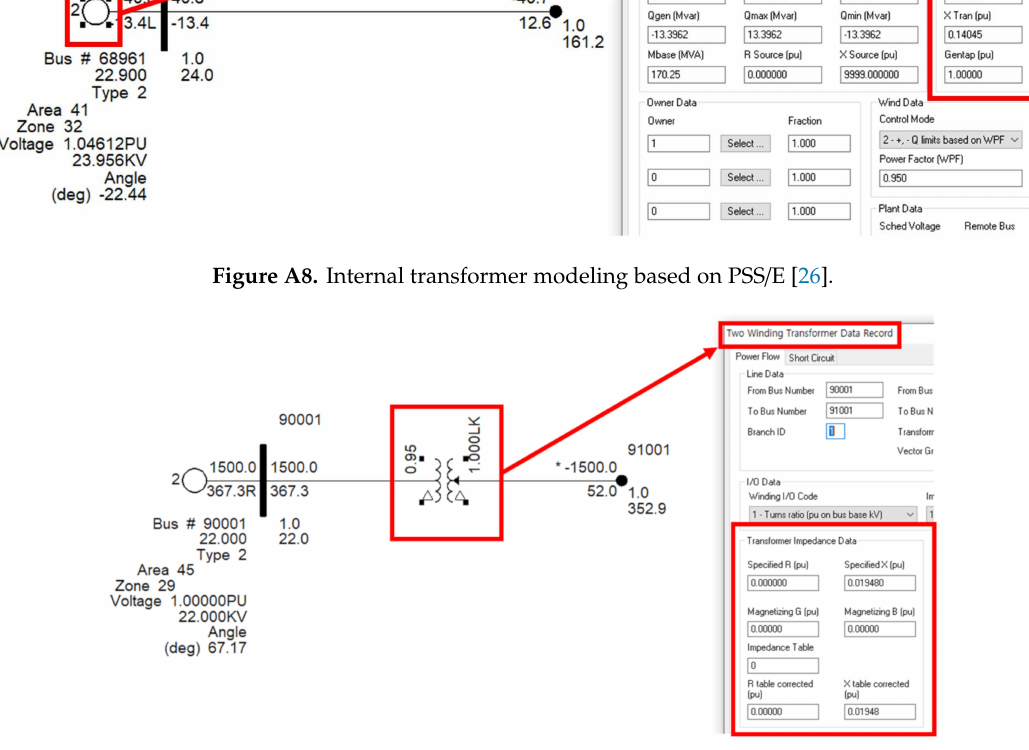
Figure A9. External transformer modeling based on PSS / E [26].